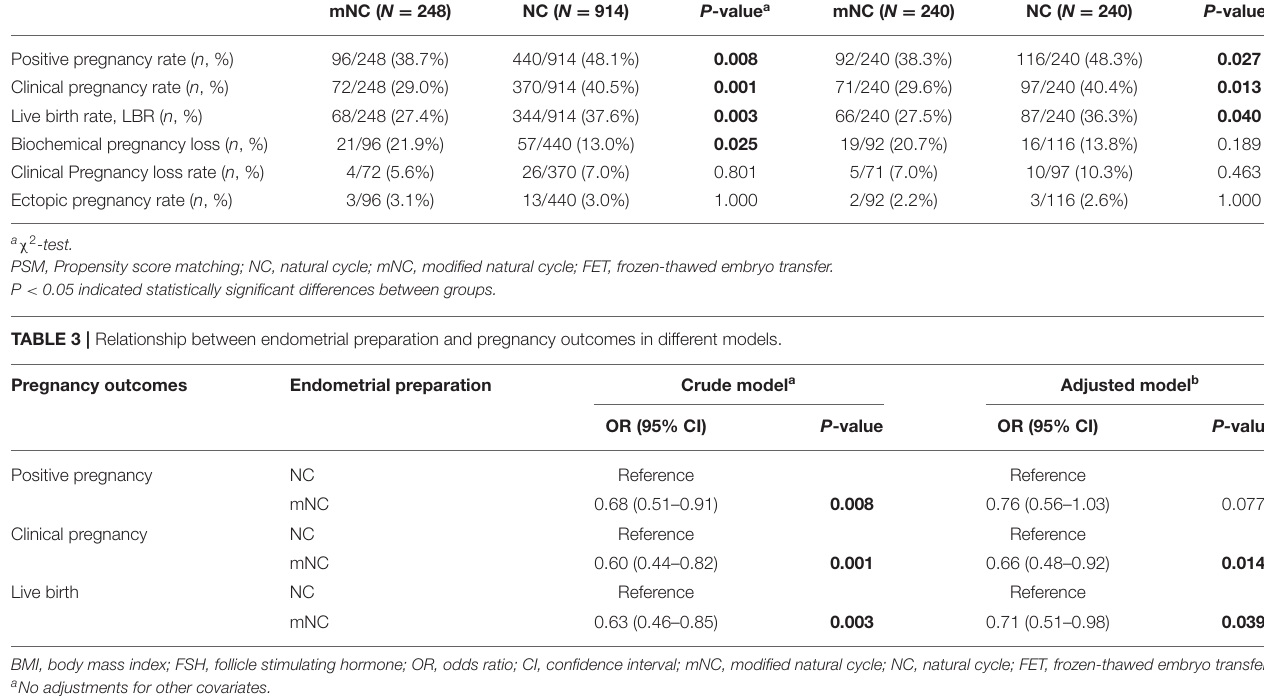
TABLE 2 | Pregnancy outcomes of FET cycles before and after PSM. Outcomes